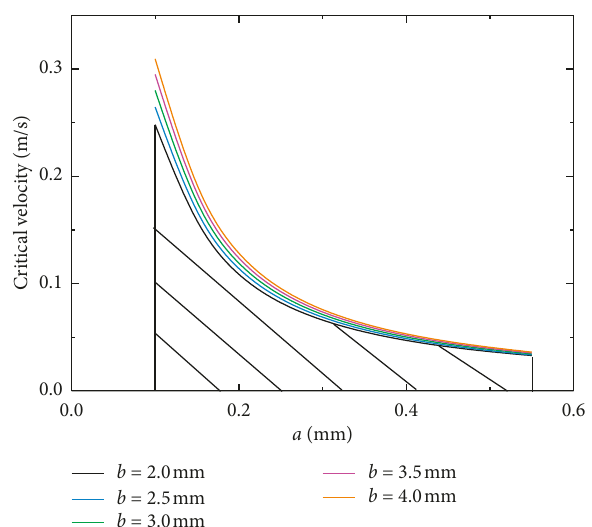
Figure 11: Relationship between particle size and critical velocity in laminar flow under four-particle arrangement.